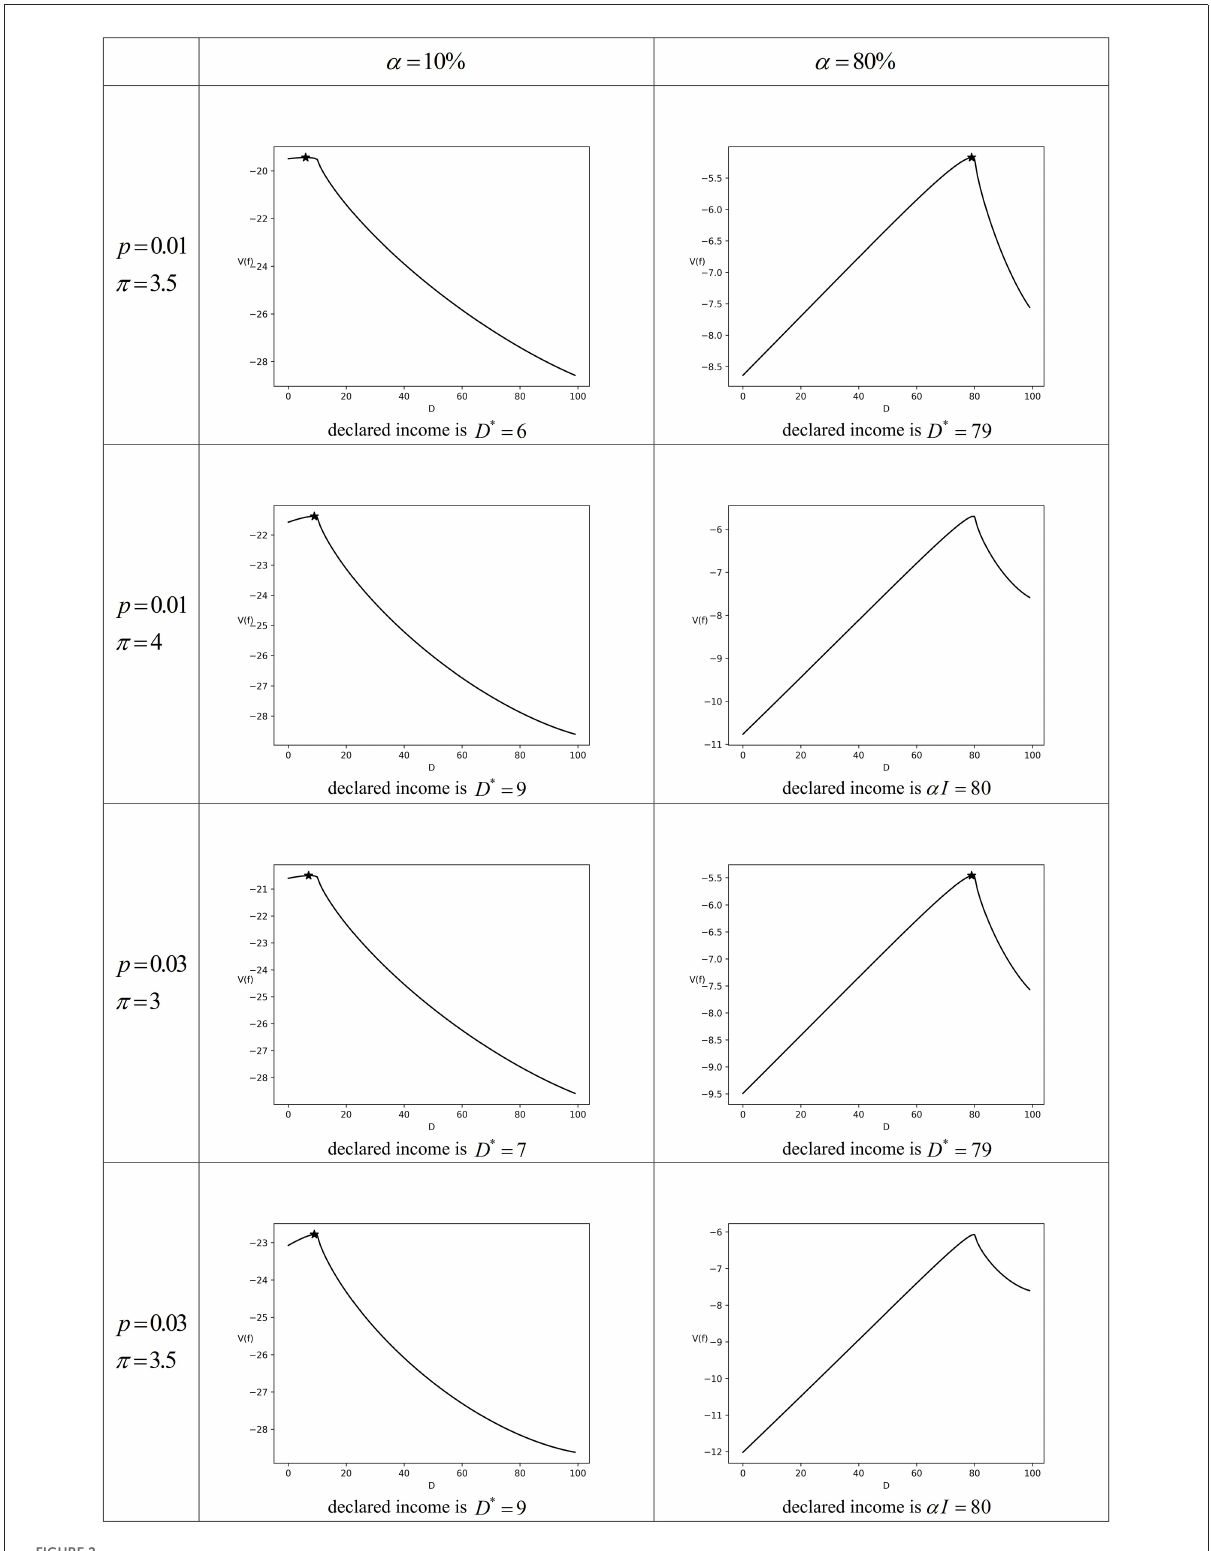
FIGURE2 The numerical simulation for Scenario 2 (partial tax